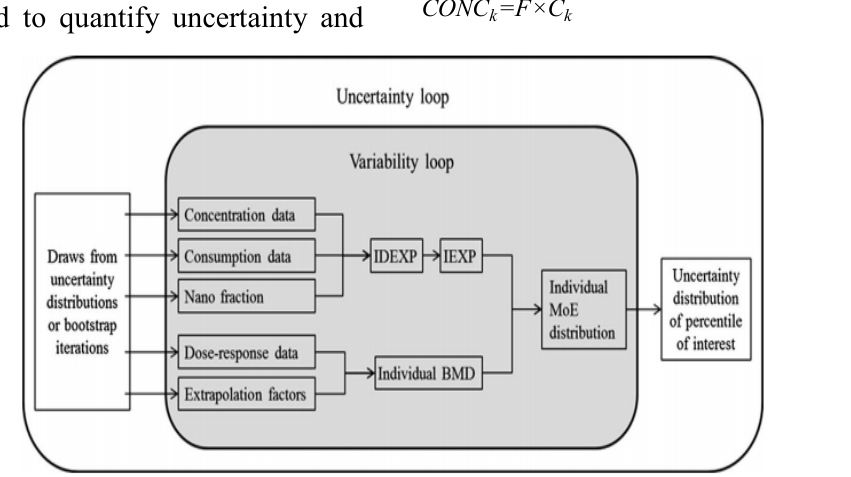
Fig. 2. A schematic diagram of uncertainty and variability loops in